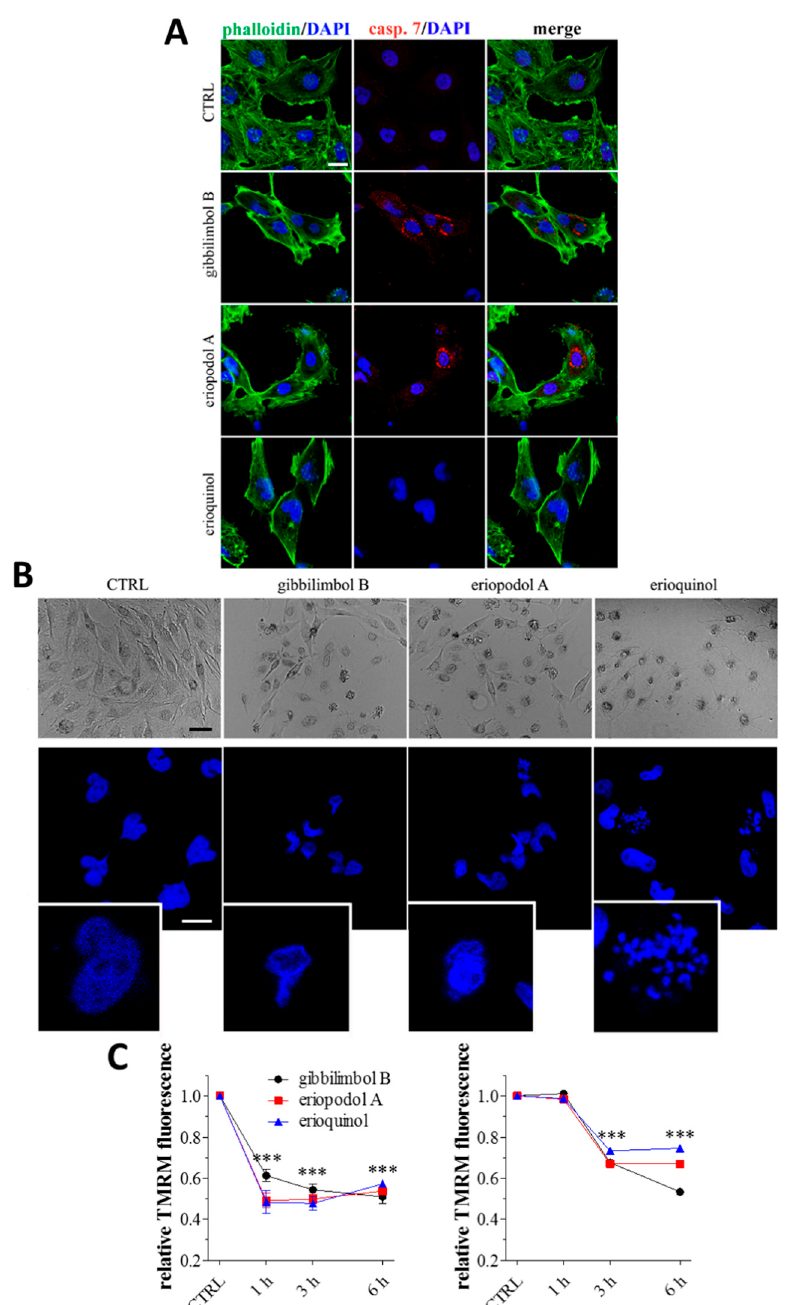
Figure 7. Piper genus-derived compounds induce cell death and mitochondrial dysfunction. ( A ) Immunofluorescence (confocal) imaging of cleaved-caspase 7 (punctate red pattern) in U373 cells treated for 6 h in the absence (CTRL, control) and in the presence of gibbilimbol B / eriopodol A (30 µ g / mL) or erioquinol (10 µ g / mL). 4’,6-diamidine-2’-phenylindole dihydrochloride (DAPI) (blue) and phalloidin (green) were used for nuclei and cytoskeleton detection, respectively. Scale bar = 25 µ m. ( B ) Bright field microscopy (upper panels) and DAPI staining (lower panels) of U373 cells treated for 6 h in the absence (CTRL) and in the presence of of gibbilimbol B / eriopodol A (30 µ g / mL) or erioquinol (10 µ g / mL). Scale bars = 50 µ m (bright field) and 10 µ m (DAPI). Lower panels represent enlarged image details. ( C ) Quantitative analysis of tetramethylrhodamine methyl ester (TMRM) fluorescence changes over time in MCF7 (left panel) and U373 (righ panel) cells in the absence (CTRL) and in the presence of gibbilimbol B / eriopodol A (30 µ g / mL) or erioquinol (10 µ g / mL). Results are expressed by setting TMRM fluorescence in the respective control (vehicle-treated) samples, i.e., absence of compounds, as 1. *** p < 0.0001 relative to CTRL. Images and data are representative of four independent